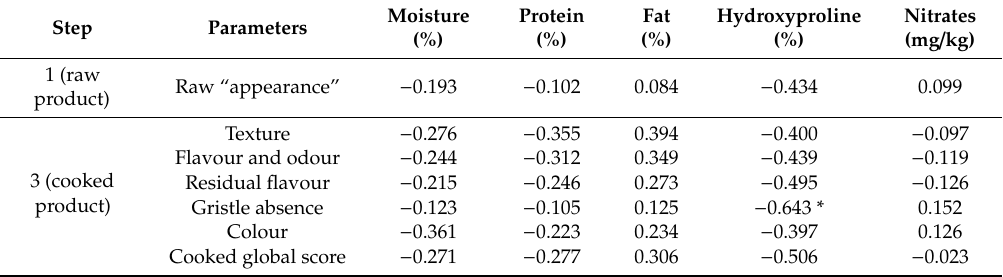
Table 3. Pearson’s correlation coe ffi cients ( r ) between sensory evaluation scores and the raw composition analysis in the samples of the step 3 ( n = 10).